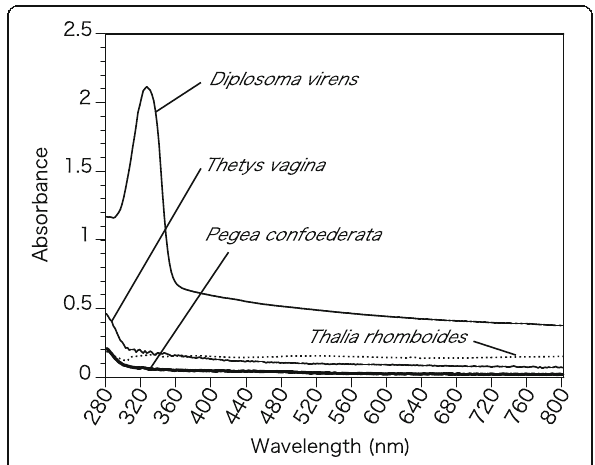
Fig. 2 Absorption spectrum of the tunic of Pegea confoederata with the spectra of Diplosoma virens , Rhopalaea sp. and Thetys vagina . The spectra of P. confoederata , T. vagina and Rhopalaea sp. have no prominent peaks, whereas the spectrum of D. virens has an absorption peak due to UV-absorbing substances